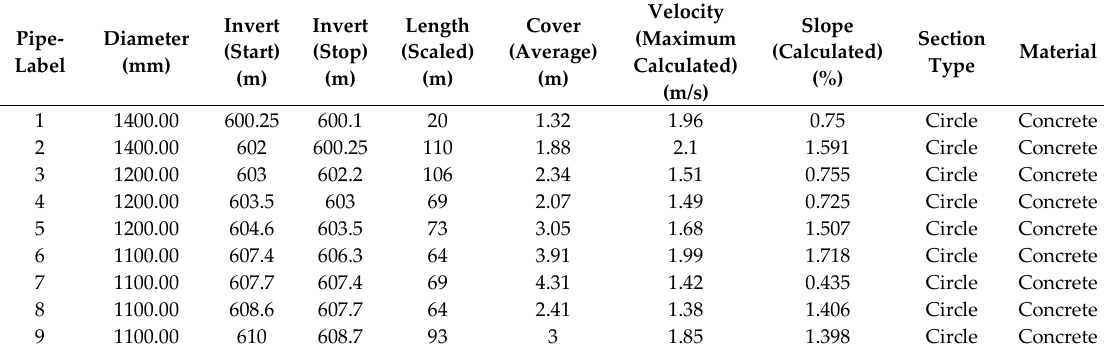
Table 5. The result of hydraulic analysis for a part of Al Naqaa catchment pipe drainage network.